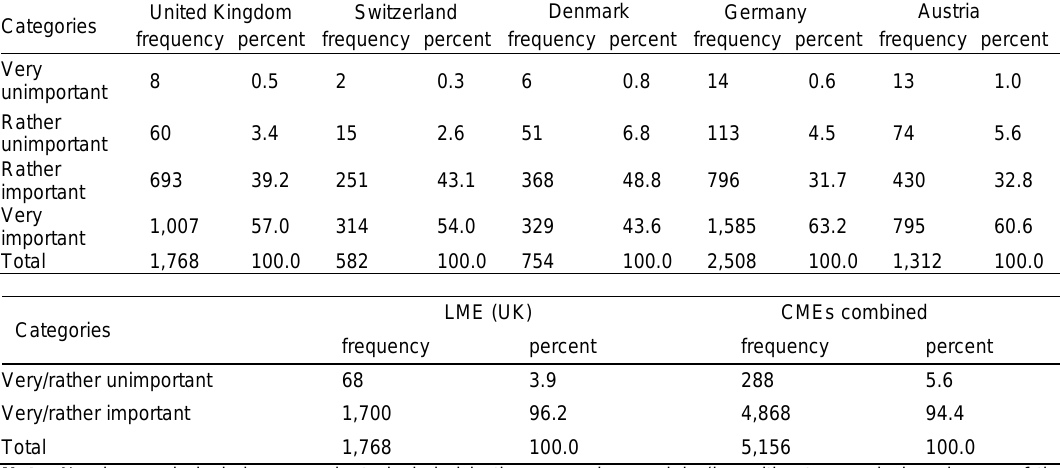
Q13a: What skills and qualities do you think are important to finding a good job in [your country]? – A good general